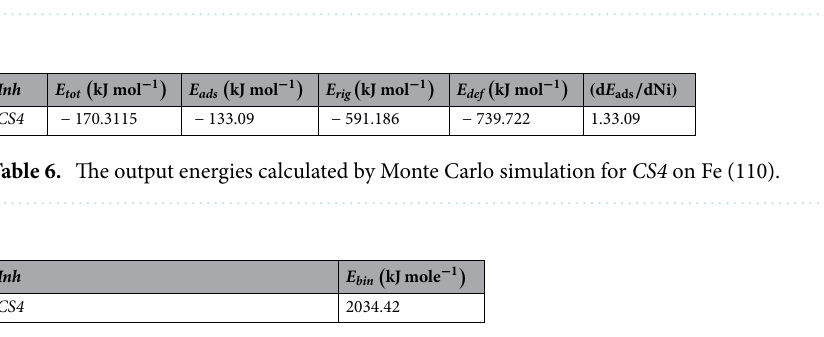
Figure 12. Distribution of the adsorption energies of CS4 on to CS -metal surface obtained via MC.